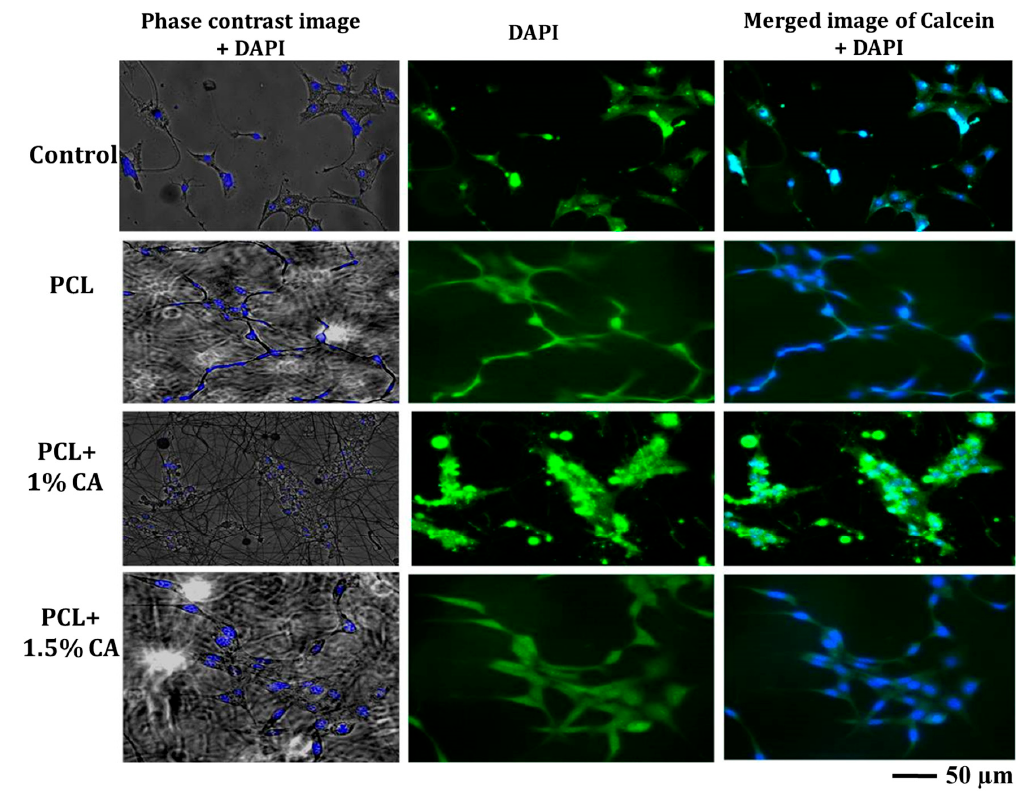
Figure 8. Cell morphology and adhesion of NIH3T3 cell line on c-spun PCL and PCL-CA fibrous mats (CA: 1 and 1.5%) on day 1 (control: TCP; DAPI: blue for nucleus and Calcein AM: green for cytoplasm).